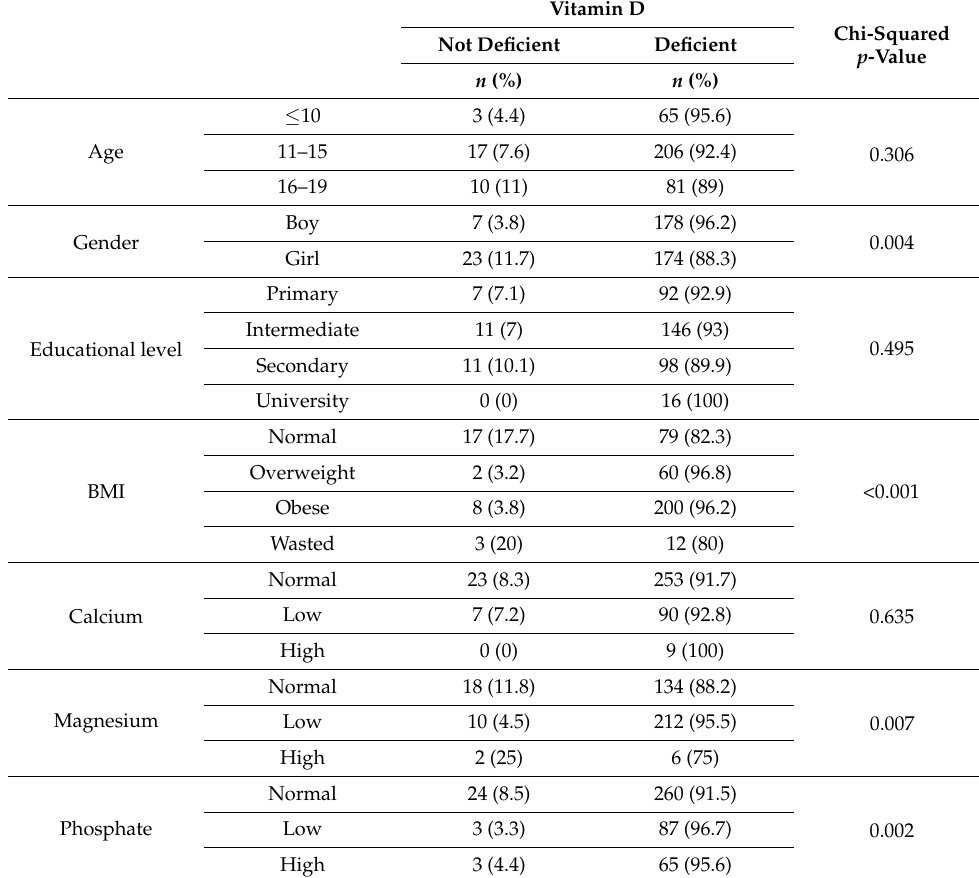
Table 3. Vitamin D in relation to participant characteristics.